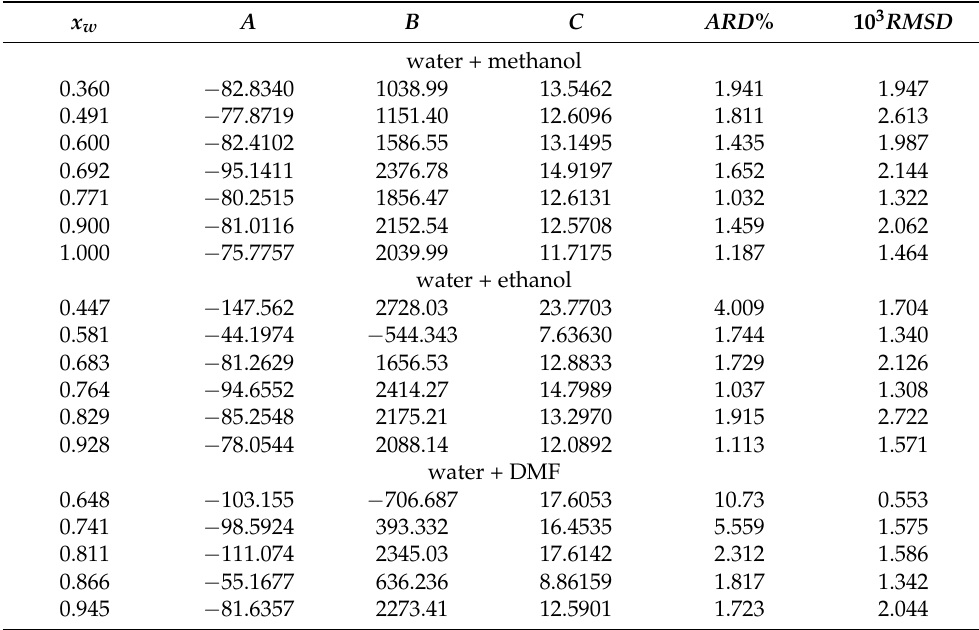
Table 6. Model parameters of modified Apelblat model for 1,5-pentanediamine adipate dihydrate in the investigated binary solvent mixtures a,b,c